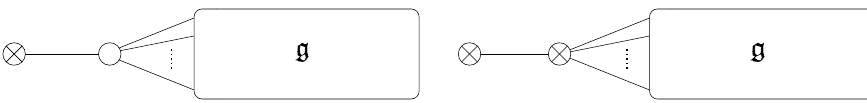
Figure 1 . Two equivalent Dynkin diagrams for B ( g + ), W ( g + ) and S ( g + ). Removing the \grey" node in the (cid:12)rst diagram yields the Dynkin diagram of g +